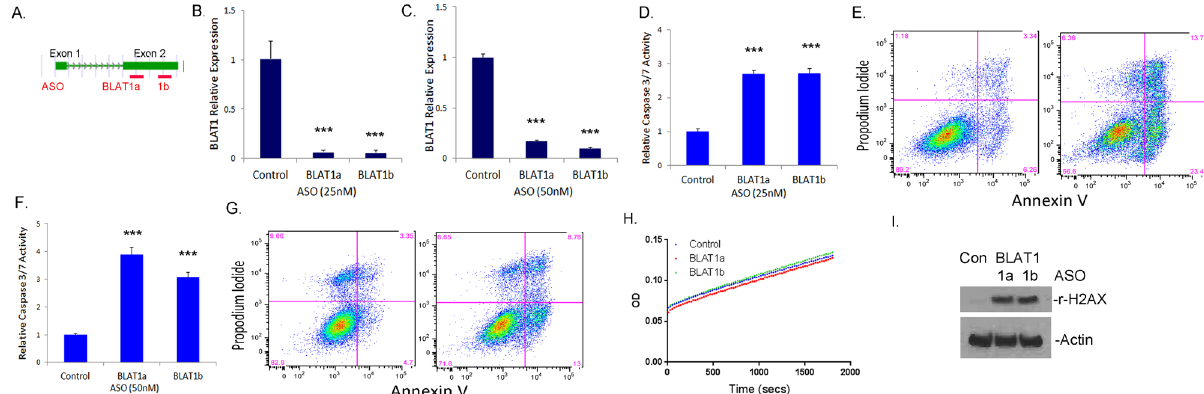
Figure 3. Knockdown of BLAT1 Expression Increased Apoptosis of BLBC cell lines. ( A ) Two different antisense oligonucleotides (ASO) targeting exon 2 of BLAT1 (BLAT1a and 1b, respectively) are indicated by red bars. ( B , C ) qRT-PCR data showed an efficient knockdown of BLAT1 expression by BLAT1a and 1b ASOs in MDA-MB-468 ( B ) and HCC-1569 cells ( C). (D, F ) BLAT1 knockdown induced significant apoptotic response in MDA-MB-468 ( D ) and HCC-1569 cells ( F ) determined by caspase 3/7 activity. ( E , G) Total apoptosis was shown to be increased by flow cytometry of Annexin V/PI stained cells 3 days after ASO knockdown in MDA-MB-468 ( E ) and HCC-1569 cells ( G ). Error bars, SE ( *** p < 0.001 vs . control-ASO treated cells). ( H ) Fifty micrograms of protein were subjected to mitochondrial OXPHOS complex I activity, which is determined by the oxidation of NADH to NAD + and the simultaneous increase in absorbance at OD 450 nm. No significant difference in the activity was observed among MDA-MB-468 cells treated with control, BLAT1a or BLAT1b ASO. ( I ) Western blot analysis showed increased expression of γ -H2AX in BLAT1a or BLAT1b ASO-treated cells, compared to the control (Con). β -Actin was used as a loading control.